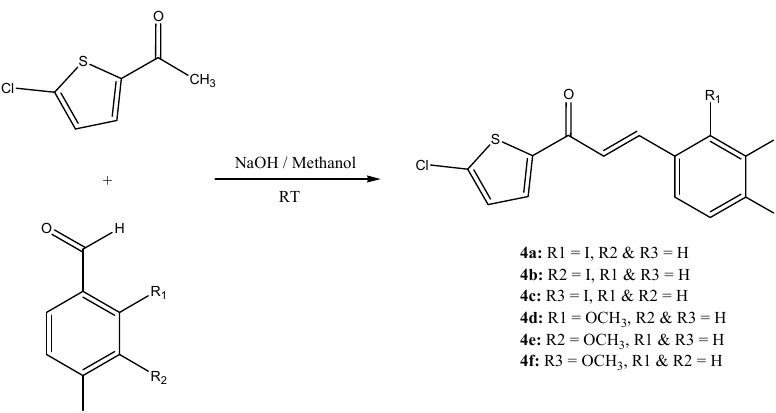
Scheme 1. Synthesis of heterocyclic chalcone